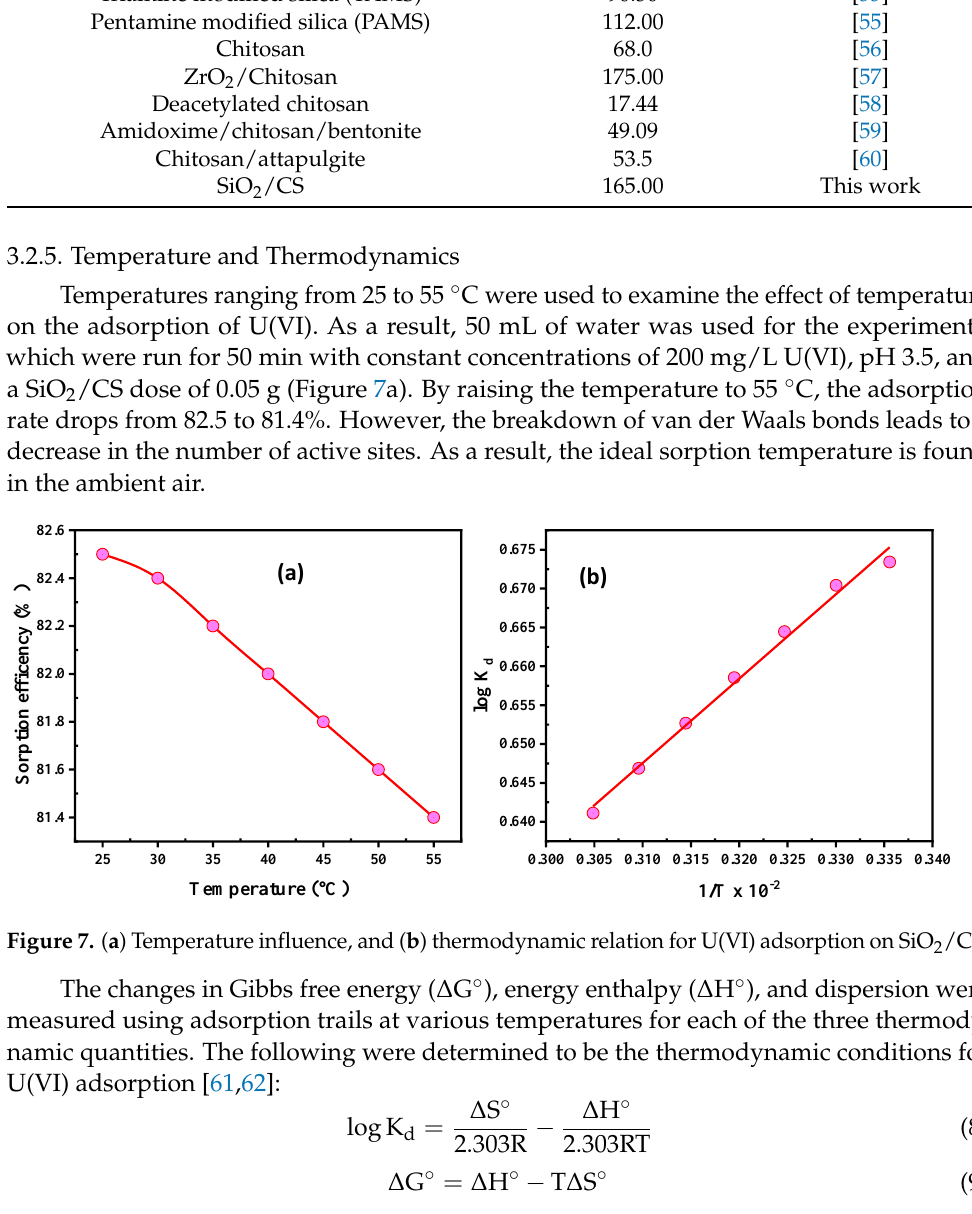
K d and R are the adsorption equilibrium constant (L/g) and universal gas constant (8.314 J/mol.K), respectively. T stands for the absolute value of a given quantity (K). The negative ∆ G ◦ values in Figure 7b and Table 5 indicate that U(VI) adsorption is spontaneous. Because the electrostatic attraction between U(VI) and SiO 2 /CS is strong, the adsorption manners were found to be preferable by analyzing the ∆ G ◦ of the interactions. A nega- tive ∆ H ◦ may advise exothermic adsorption. ∆ S ◦ was negatively biased, indicating that adsorption could occur orderly at the interface between the adsorbent and the solution. Table 5. Thermodynamic U(VI) adsorption settings at SiO 2 /CS.